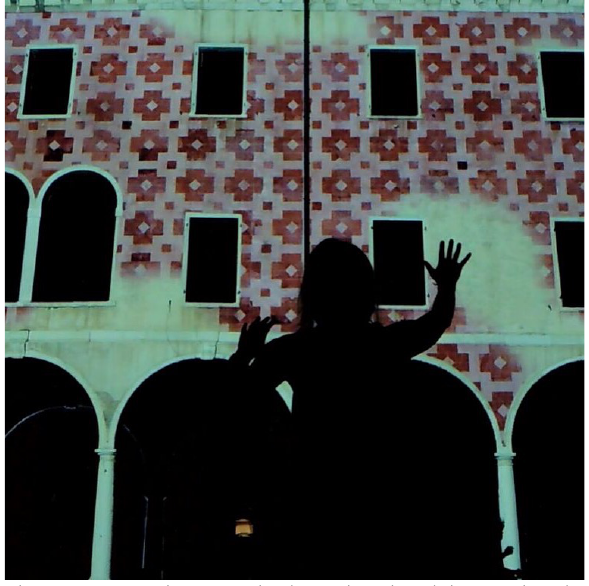
Figure 5. Interactive event in the University cloister, using the infrared Kinect® sensor.